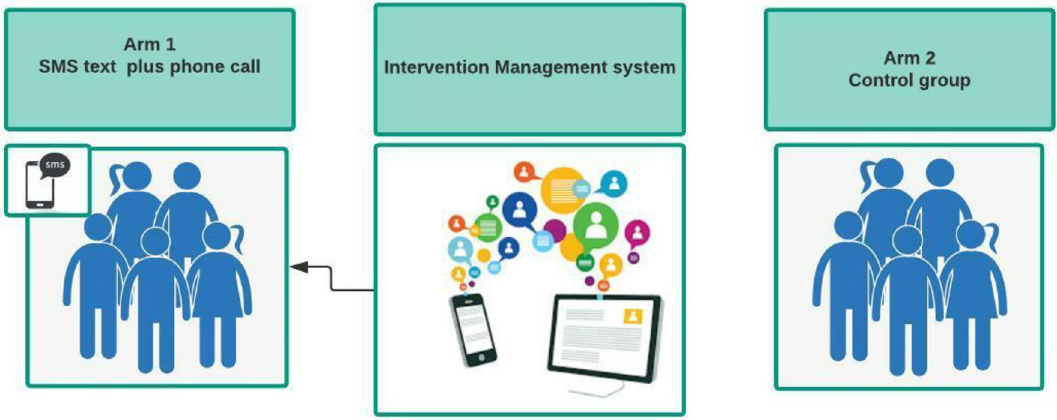
Fig 2. Mobile-assisted Medication Adherence Support (Ma-MAS) intervention diagram.